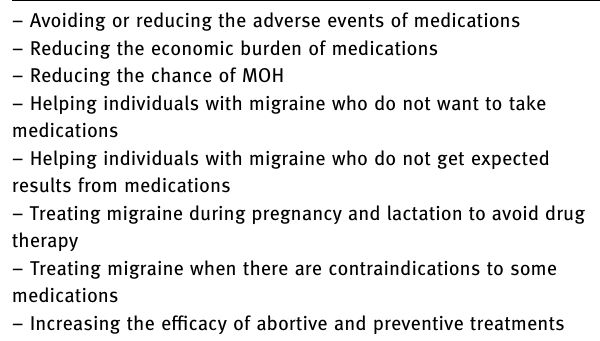
Table 1: Bene fi ts of non - pharmacological migraine